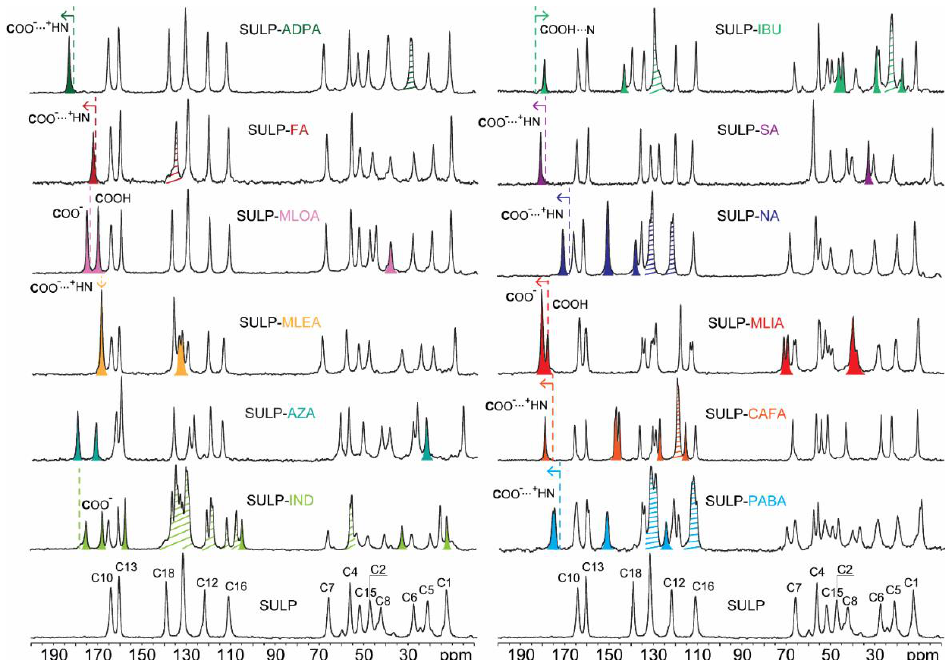
Figure 8. 13 C (100 MHz) CPMAS spectra of SULP (with assignment) and of all the 12 achieved adducts, acquired with a spinning speed of 12 kHz at room temperature. The COOH signals of the pure coformers are represented by the colored dashed lines in each spectrum to highlight the shift undergone upon cocrystallization. Colored peaks represent signals ascribable to the coformer. Striped peaks result from the overlap of coformer signals with those of SULP. The numbering of the SULP atoms refers to Scheme I.